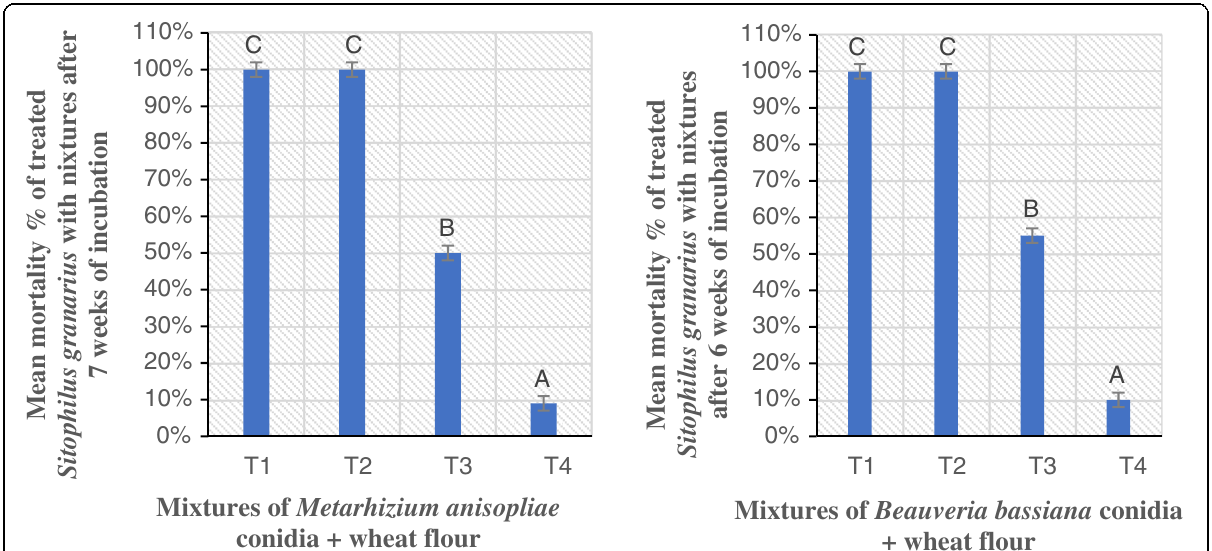
Fig. 2 Mortality of Sitophilus granarius adults . Means followed by the same letter are insignificantly different at P = 0.05 using ANOVA and Scheffe for means comparison. Ratios of mixtures ( w / w ) are T1=0.2:2.0; T2=0.1:2.0; T3=0.05:2.0;